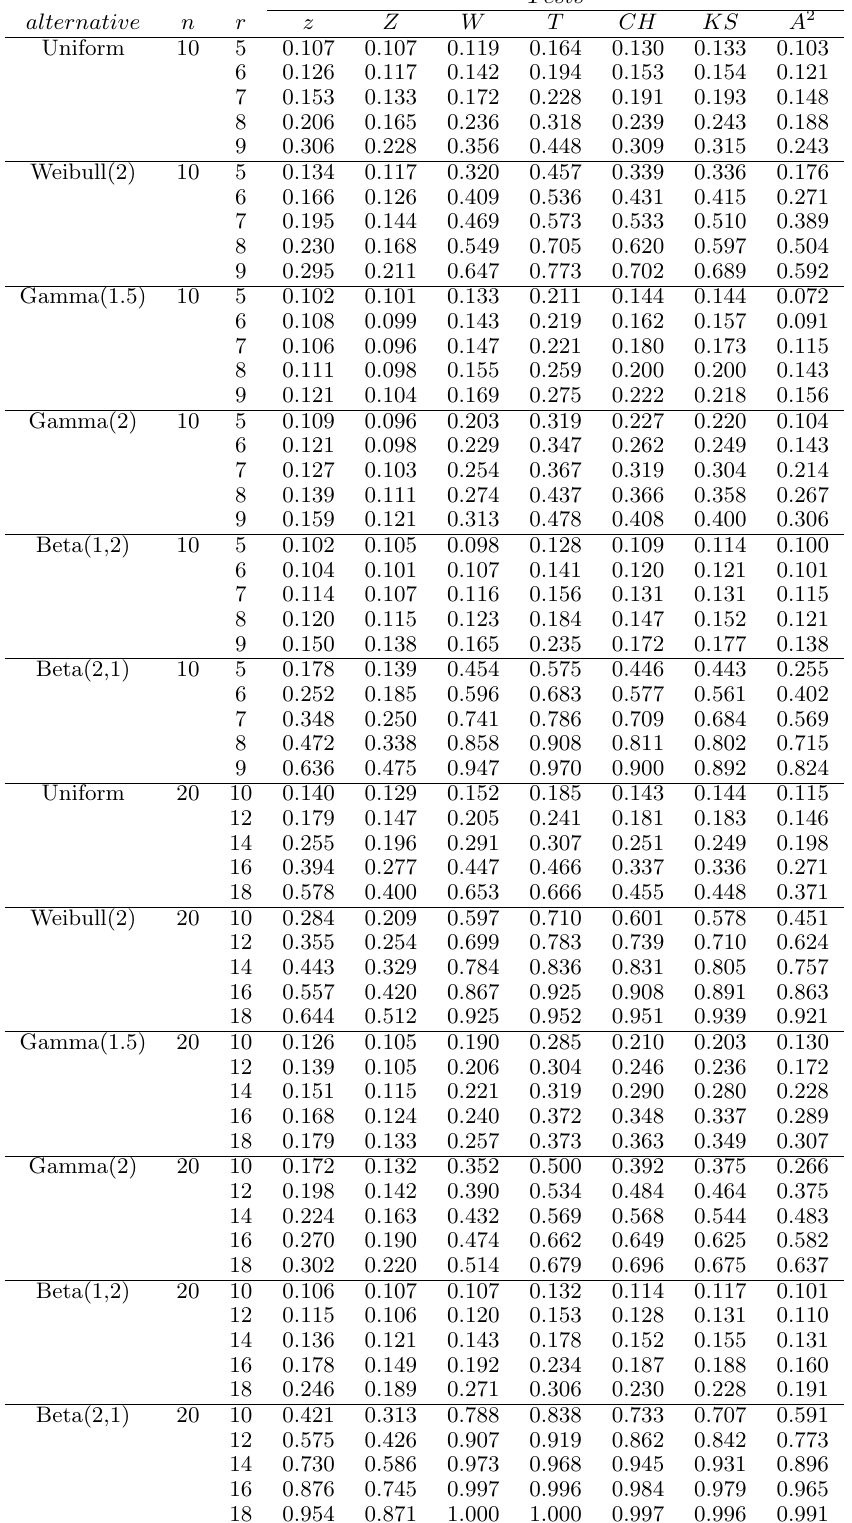
Power comparison at 10 % signi(cid:12)cance level: monotone increasing hazard